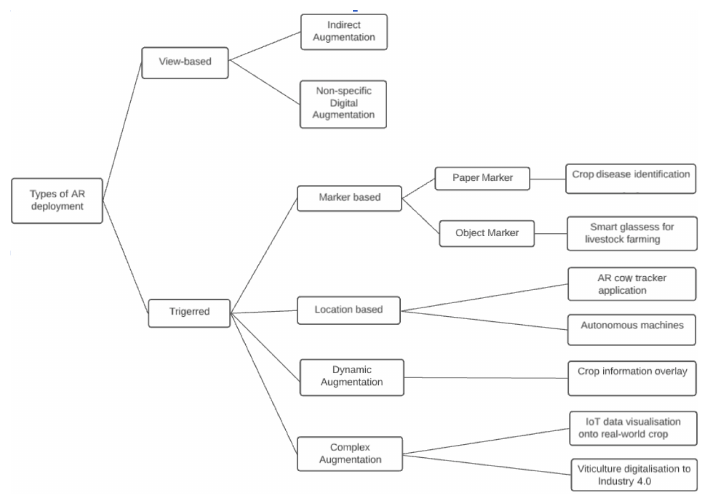
Figure 5. Types of AR deployment within crop and livestock management. Please refer to the excellent overview by Hurst et al. (2021)